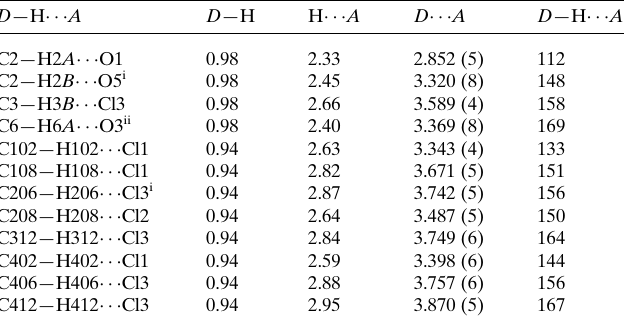
Table 4 Hydrogen-bond geometry (A˚ , (cid:3) ) for 6 .